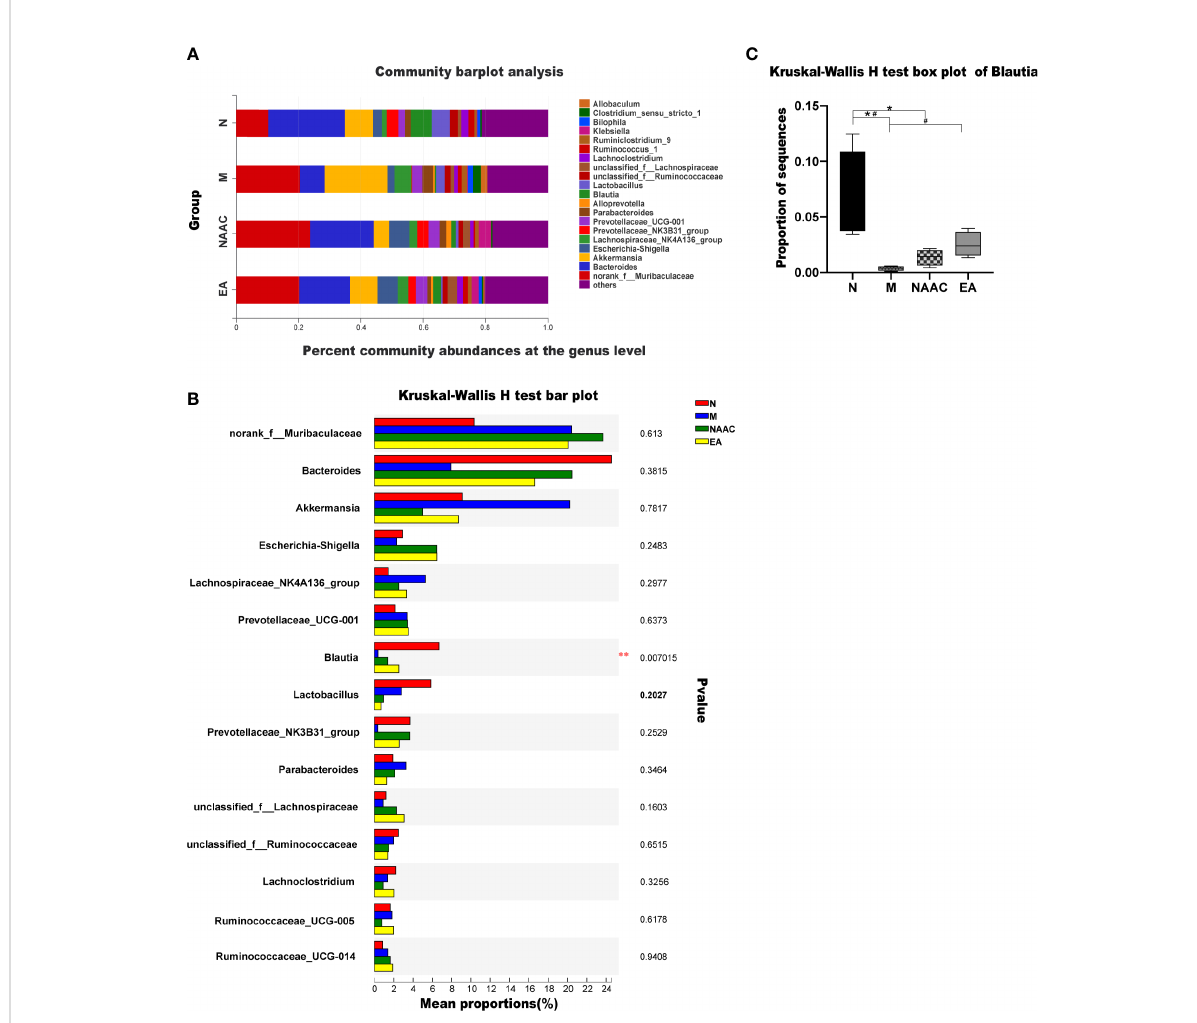
FIGURE 3 Community bar plot analysis showing the fl ora community composition at the genus level. The dominant bacteria in the N group and the EA group were the same, namely, Bacteroides and norank_f_Muribaculaceae (A) . The Kruskal – Wallis rank-sum test bar plot shows the top 15 species with the most abundant expression at the genus level (B) . *0.01< P <=0.05, **0.001< P <=0.01. The relative abundance of Blautia in each group was analyzed via the Kruskal – Wallis test (H = 12.110, P=0.007, <0.05) (C) . *P < 0.05 compared with the N group; # P < 0.05 compared with the M